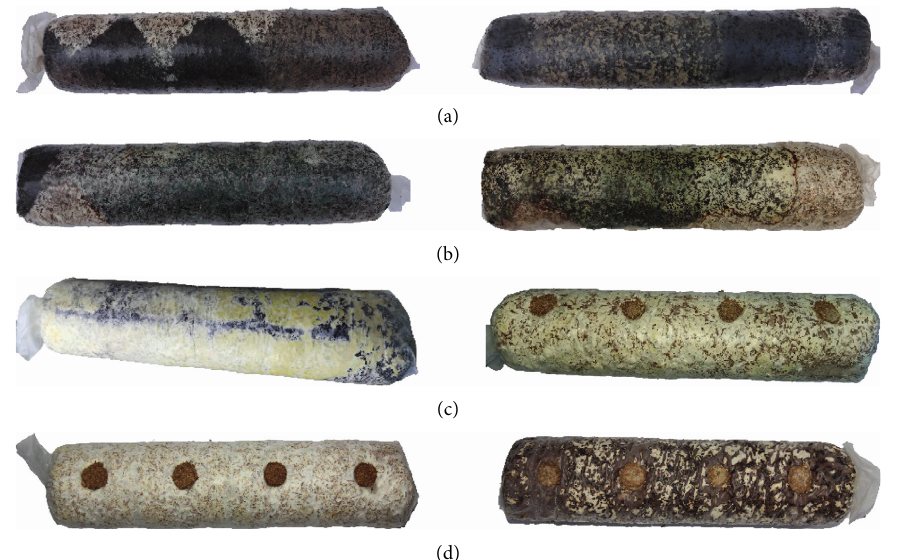
Figure 1: Examples of diseased Lentinus edodes sticks and normal Lentinus edodes stick images. (a) Aspergillus flavus diseased sticks. (b) Trichoderm viride diseased sticks. (c) Neurospora diseased sticks. (d) Normal Lentinus edodes sticks.